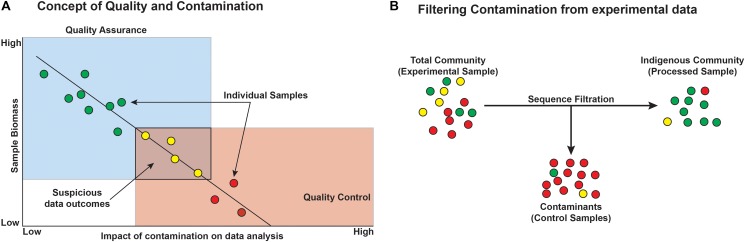
Conceptual outcomes of contamination and the general removal of contaminants from datasets. (A) Microbial contamination and its impacts on the study are a function of microbial biomass, such that with decreasing biomass, the likelihood and impact of contamination increase and must be considered when designing the experiment. Colors represent minimal (green), some (yellow), and high (red) contamination signal. (B) Filtering contaminants from existing datasets can be aided by sequencing control blank samples, ideally from each step of the experiment. Circles represent individual operational taxonomic units (OTUs) or phylotypes and the colors represent green = taxa that are authentic to the environment, yellow = suspicious taxa, and red = contaminant taxa.